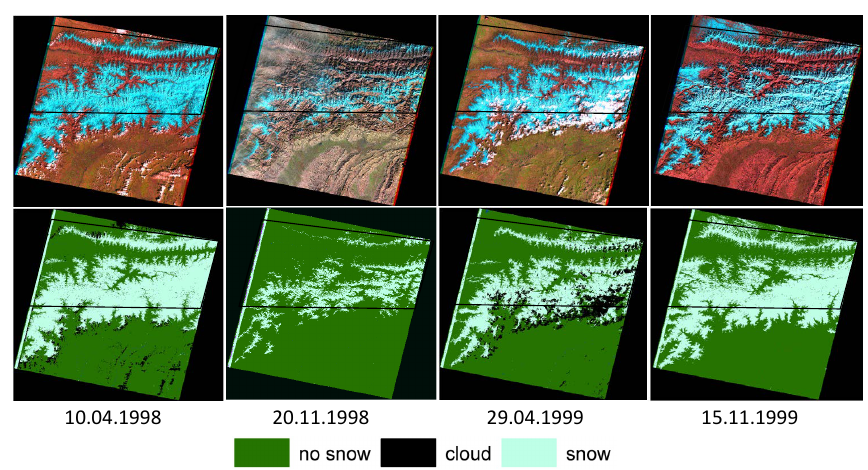
Figure 3. Original Landsat scenes (top row) and derived snow-cover maps used for validation (bottom row). Black outlines show the valida- tion domain for Zerafshan